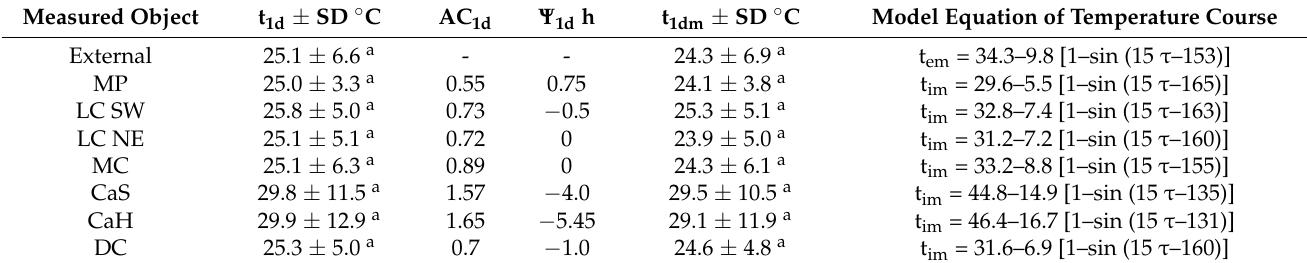
Table 4. The results of measured average air temperatures t 1d ± SD ◦ C, attenuation coefficient AC 1d , time shift of temperature maximum Ψ 1d , model curve equations expressing the course of air temperature during 24 h of the hot summer day and average temperatures t 1dm ± SD ◦ C calculated from model waveforms. Identical superscript letters ( a ) are a sign that there is not a significant statistical difference ( ANOVA ; Tukey’s HSD test ; p ≤ 0.05) between measured value t 1d ± SD ◦ C and model value t 1dm ± SD ◦ C in the same line. Identical superscript letters for numbers in a line indicate that there is no statistically significant difference between measured and modeled values.